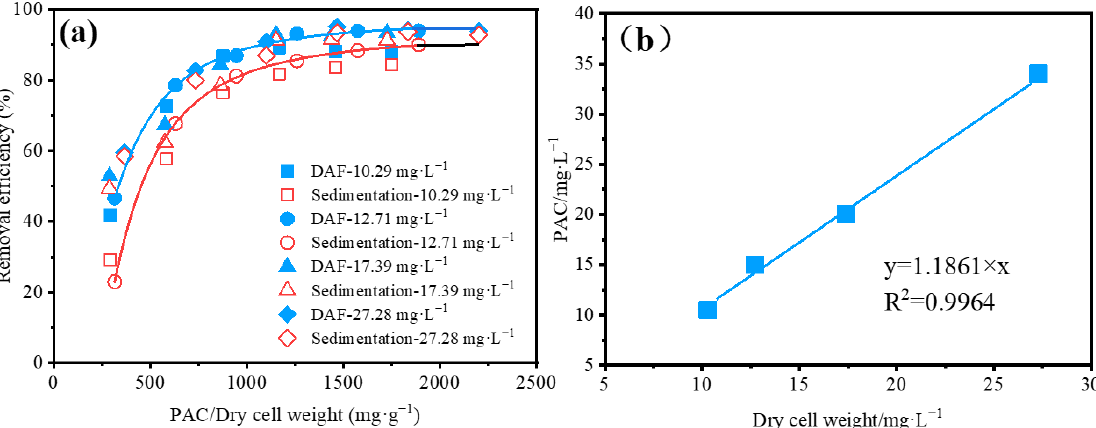
Figure 3. ( a ) The performances of DAF and sedimentation in removing algae cells from different types of raw water (pH 7, temperature 28°C, algae concentrations were 10.29 mg ∙ L − 1 , 12.7 mg ∙ L − 1 , 17.39 mg ∙ L − 1 and 27.28 mg ∙ L − 1 , respectively), ( b ) relationship between PACl dosage and algae cells when coagulation reaches the best level based on 4 different raw waters.